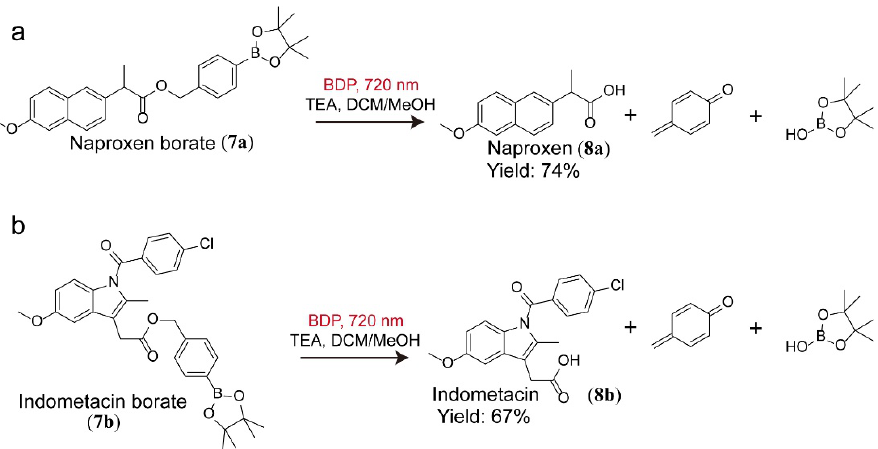
Figure 4. NIR light–driven photolytic activation of the prodrug naproxen borate ( a ) and indometacin borate ( b ) with BDP as the photocatalyst.